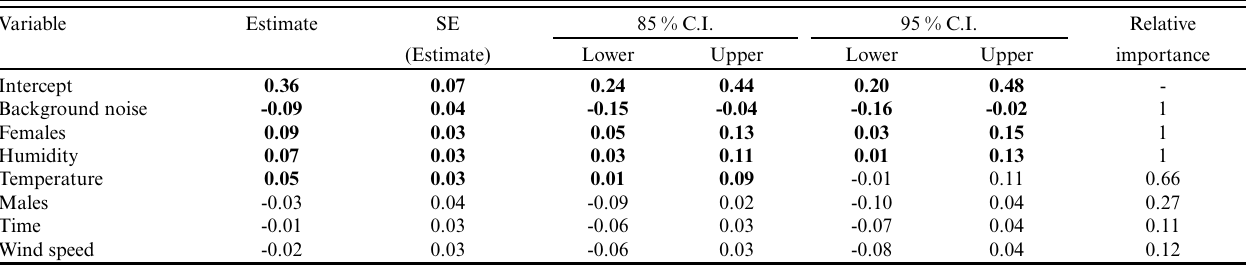
Table 4 . Influence of fixed effects on Greater Prairie-Chicken ( Tympanuchus cupido ) boom propagation from leks near Ainsworth, Brown County, Nebraska, USA, 2013–2014. Significant and marginally significant fixed effects, based on 85% and 95% confidence intervals, respectively, shown in bold. Estimates (±SE) are derived from model-averaging of the set of 6 models < 2 Δ AIC model.